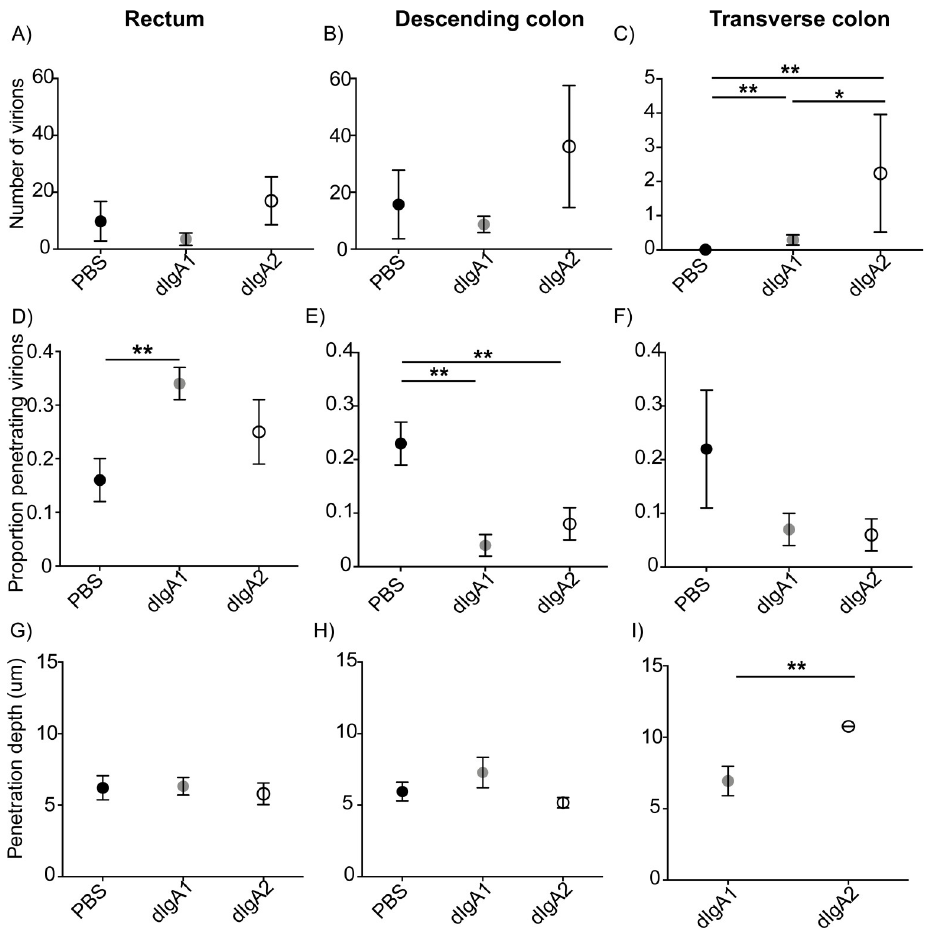
Fig 4. dIgA antibodies impact virion distribution and penetration after rectal challenge. Quantification of three outcome measures for the experiment in Fig 3 (see “Outcome Measures” in Methods). ( A-C ) total number of virions counted in images ( D-F ) proportion of penetrating virions ( G-I ) penetration depth. A,D,G: Rect um; B,E,H: Descending colon; C,F,I: Transverse colon. Circles and bars, estimated means and standard errors; n = 6 animals/ group (18 animals total); � , P < 0.02; �� , P <